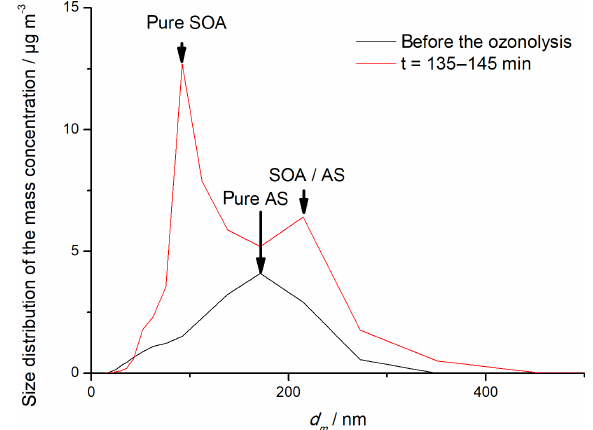
Figure 4. Particle mass size distribution before and 10min after the addition of ozone.